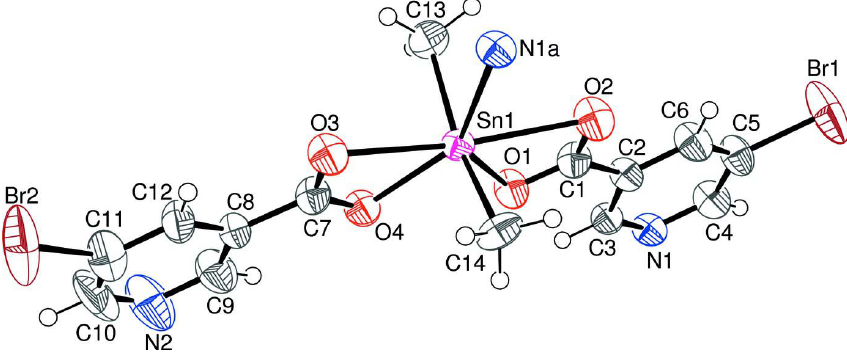
The molecular structure of (I) showing 50% displacement ellipsoids (arbitrary spheres for the H atoms). N1a is at the symmetry position ( x , y + 1, z